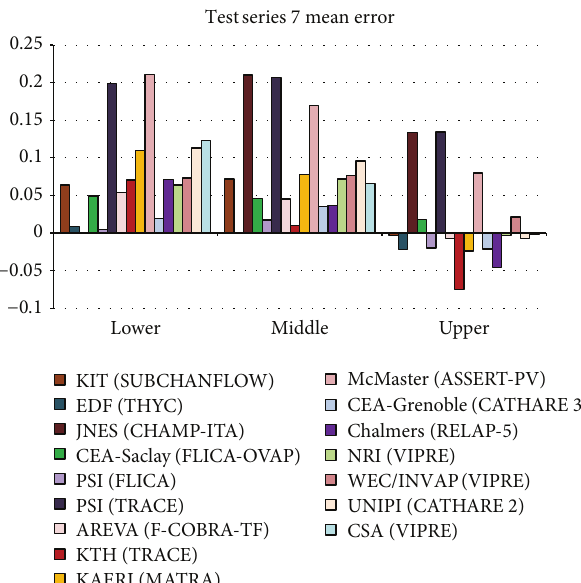
Figure 29: Test series 8 void fraction mean error.